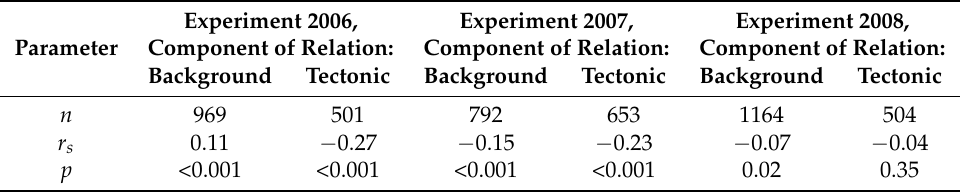
Table 1. Background ( P s < P ∗ s ) and tectonic ( P s > P ∗ s ) components parameters of the relation between the hourly mean values of atmospheric electric field potential gradient V (cid:48) and acoustic pressure P s during calm weather conditions (see the